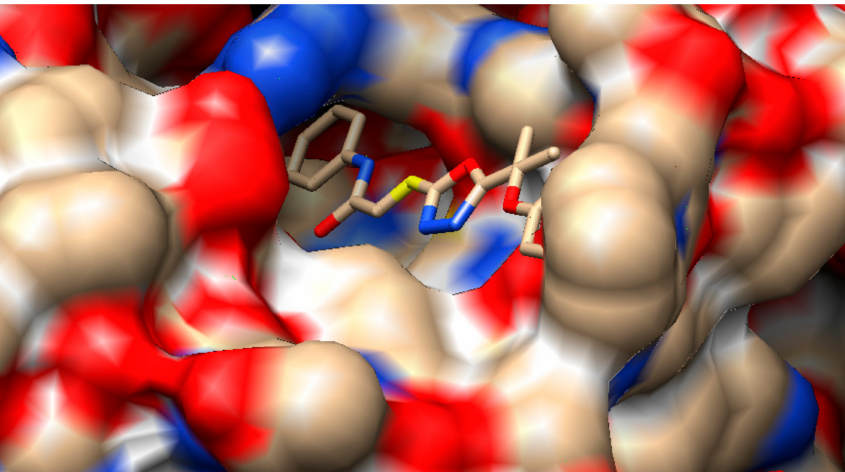
Figure 3. Hyde affinity analysis of most active inhibitor 3a . The favorably contributing structural elements (atoms and torsions) to the overall binding energy colored blue, unfavorably are colored in red, and neutral elements are in